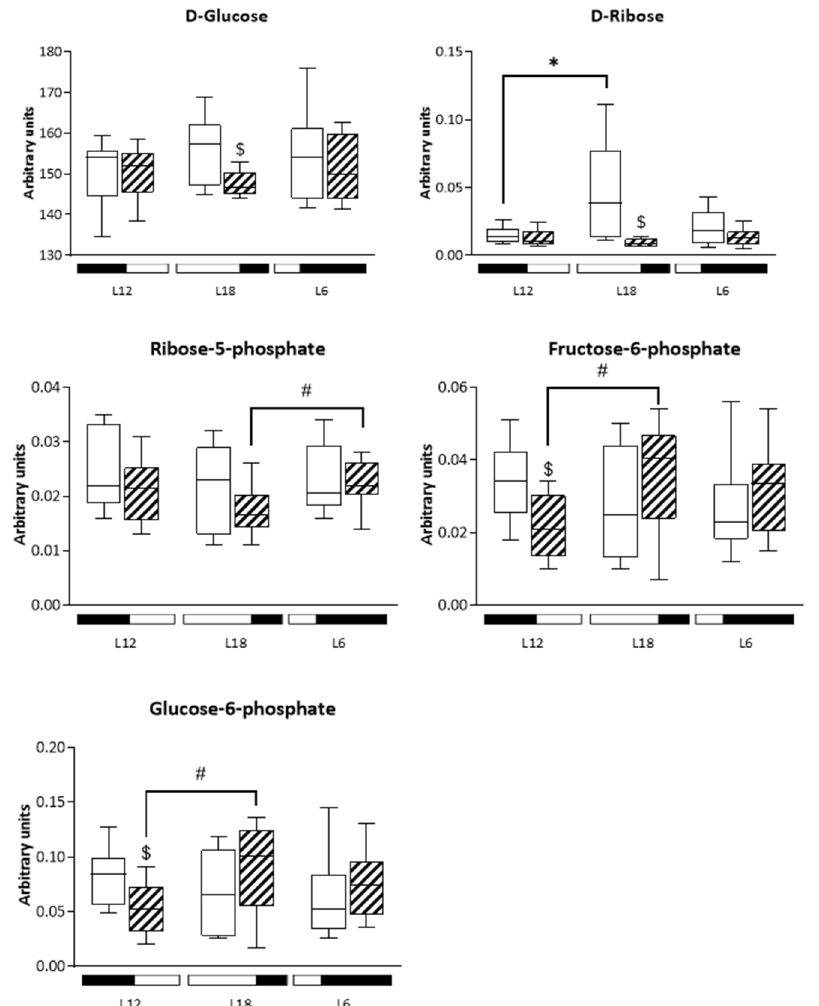
Figure 5. Metabolites related to hepatic glucose metabolism. Metabolites of glucose metabolism in the liver of Fischer 344 rats treated with VH or GSPE exposed to standard (12 h light:12 h dark), long (18 h light:6 h dark), or short (6 h light:18 h dark) photoperiods fed with STD diet ( n = 8). The results are presented as the mean ± SEM. * indicates significant differences within VH groups (Student’s t test, * p < 0.05); # indicates significant differences within GSPE groups (Student’s t test, # p < 0.05); $ indicates significant differences between treatments (VH vs. GSPE) (Student’s t test, $ p < 0.05).